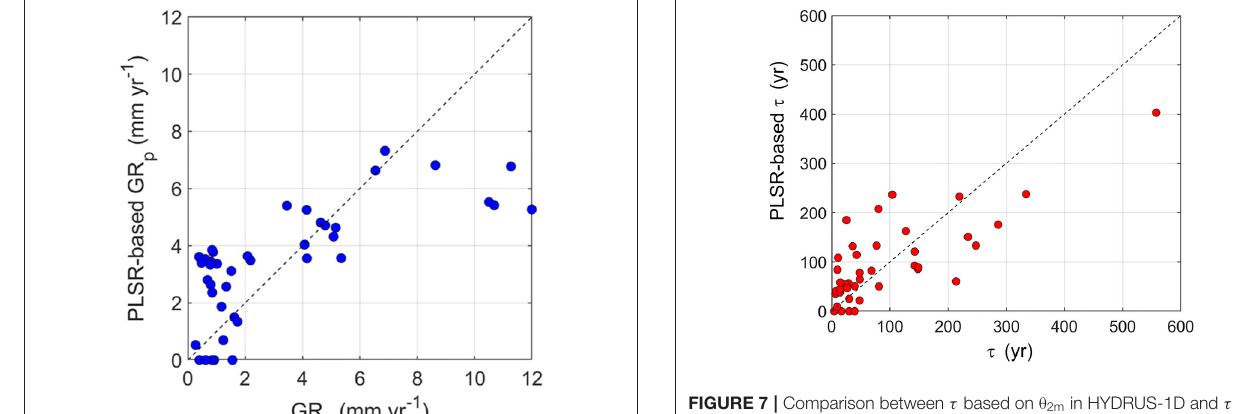
FIGURE 7 | Comparison between τ based on θ 2m in HYDRUS-1D and τ modeled by using PLSR over the 41 weather